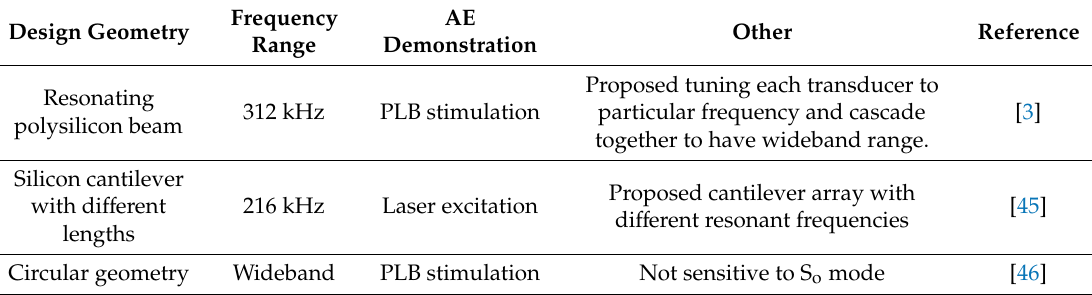
Table 2. Piezoresistive MEMS AE sensors and their